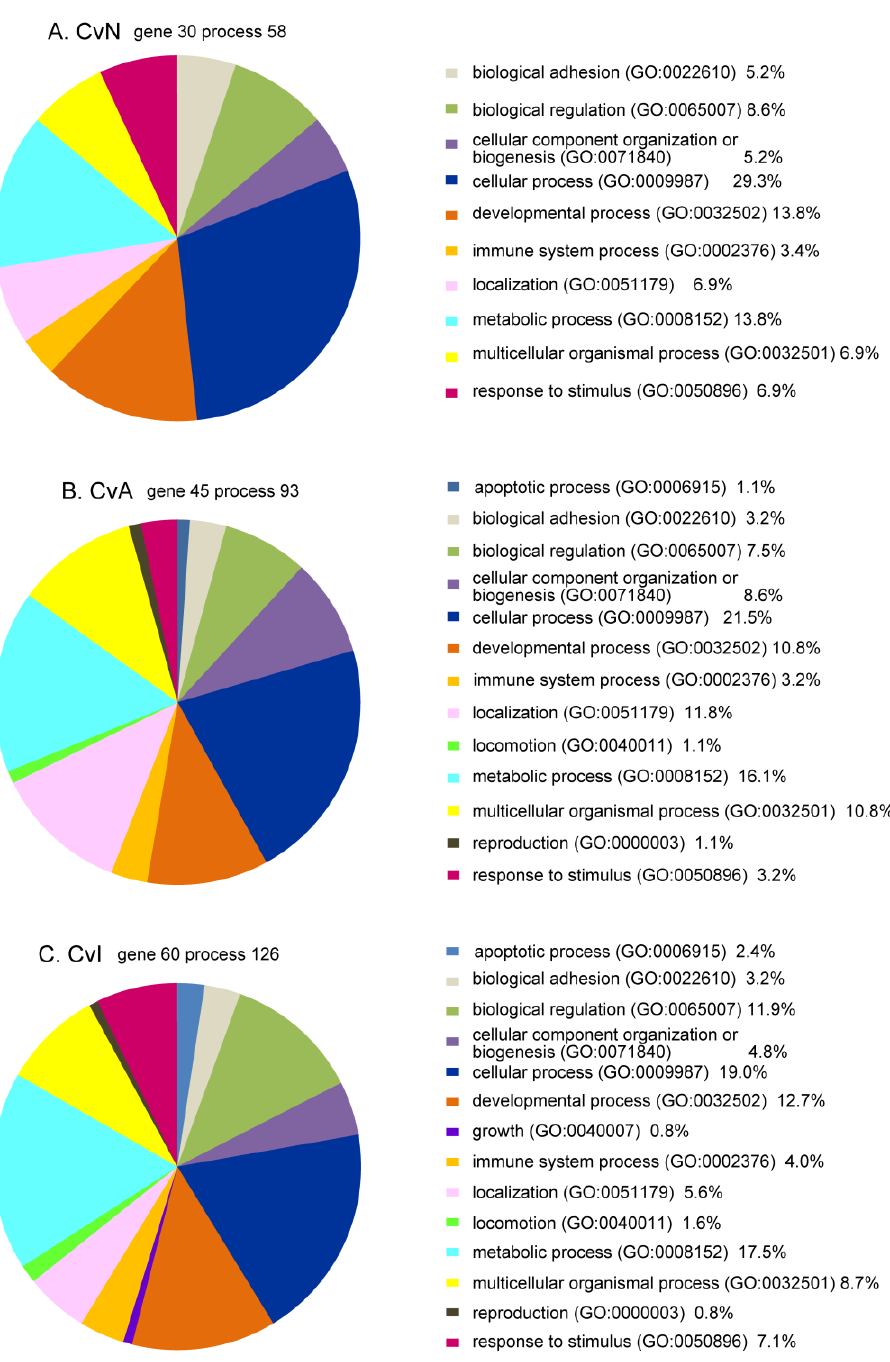
Figure 7. Gene ontology (GO) biological process analyses of differentially expressed (DE) genes for control versus nicotine (CvN), acetamiprid (CvA), or imidacloprid (CvI) in pie charts A, B, and C, respectively. Each gene list was applied to PANTHER software. GO biological processes are shown in pie charts, CvN ( A ), CvA ( B ), and CvI ( C ). A number of genes were not recognized by the PANTHER system, including Ndufaf2 and Sdr42e2 (common to all three lists); Car3 and LOC317356 (CvN); LOC100363332 (CvA); Cyp4a1, Klk1c7, LOC100364862, LOC100912563, and LOC294497 (CvI).